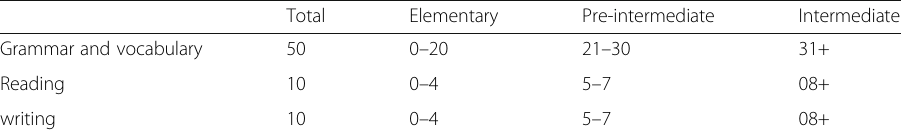
Table 4 Cut scores of oxford solutions placement